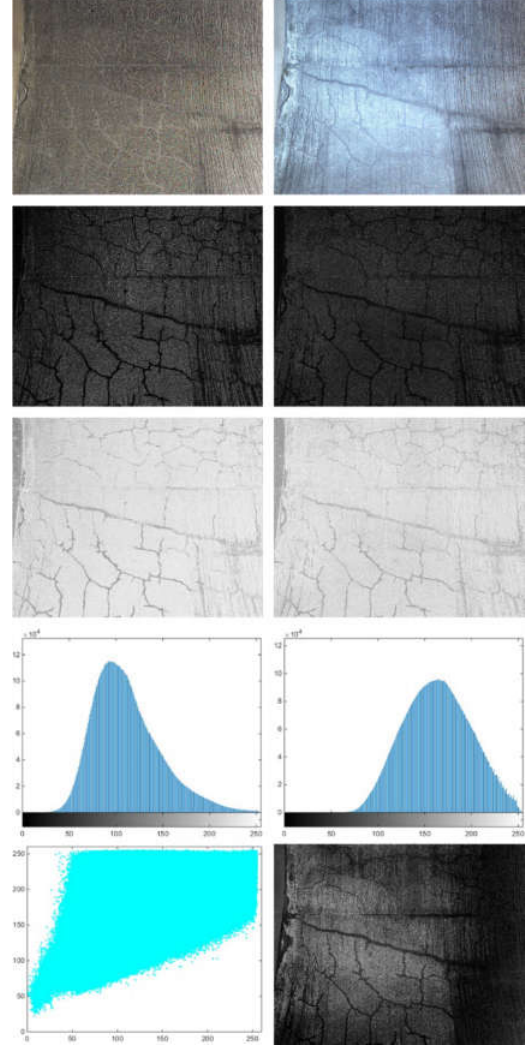
Figure 1. Radiometric changes on the dataset images. First row : two potential instances of the same image. Second row : the standard deviation of each image’s pixels is displayed in a neighbourhood of 5 pixels. Third row : the local entropy of the two image instances is displayed. The f ourth row includes the two histograms. Last row : the function of the two images intensities is presented, only to show that the radiometric changes are not linear; on the right the image of their differences is